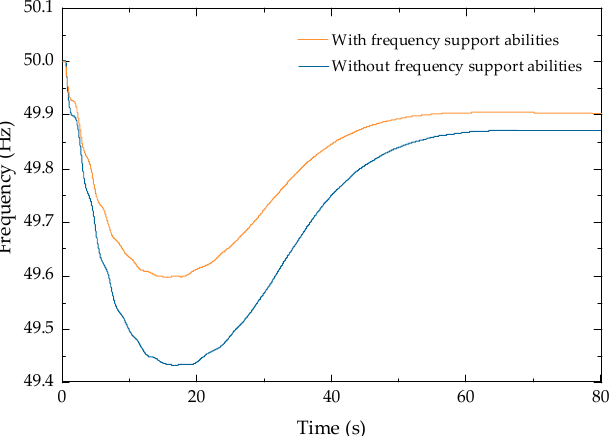
Figure 16. Frequency characteristic curves when all the nonsynchronous-machine sources are con- trolled with and without frequency support abilities, respectively.